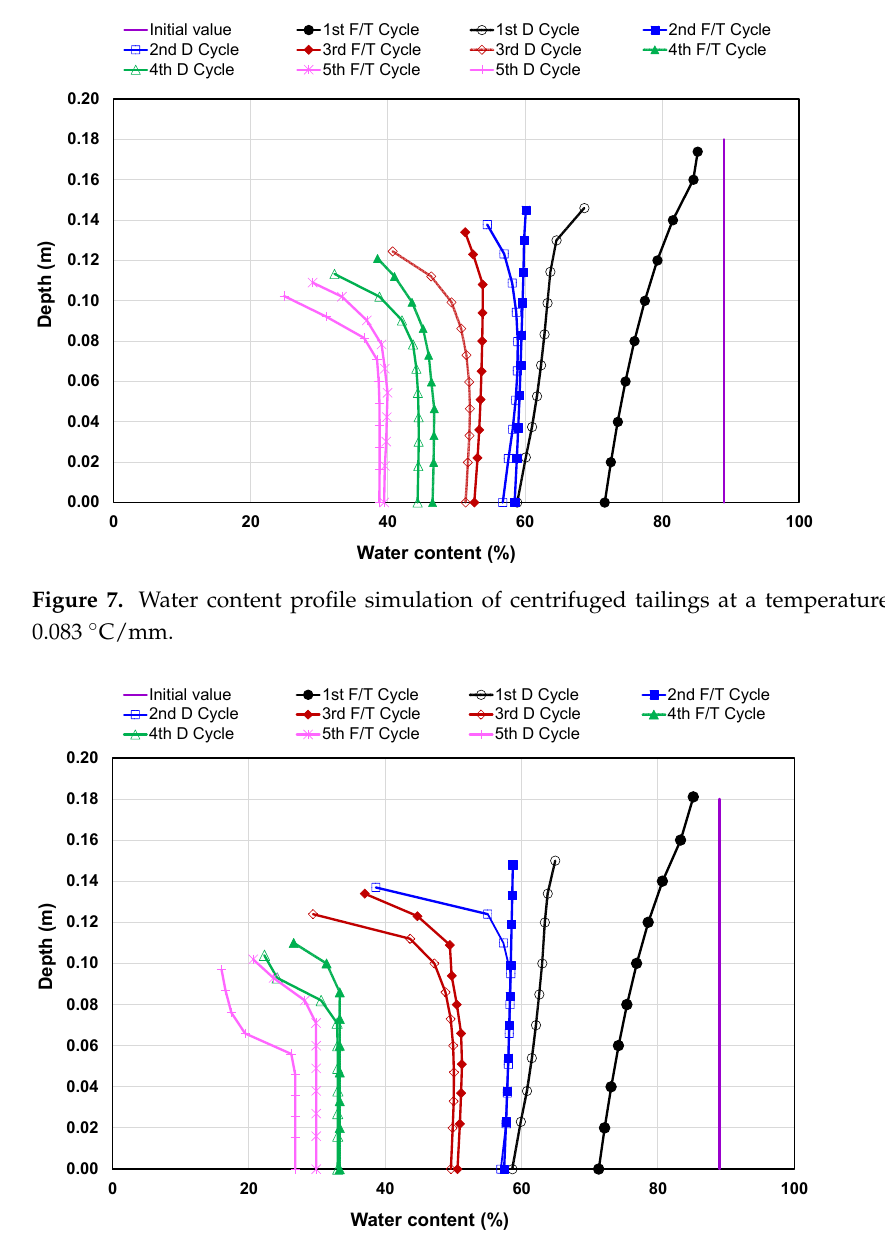
Figure 8. Water content profile simulation of centrifuged tailings at a temperature gradient of 0.028 °C/mm.